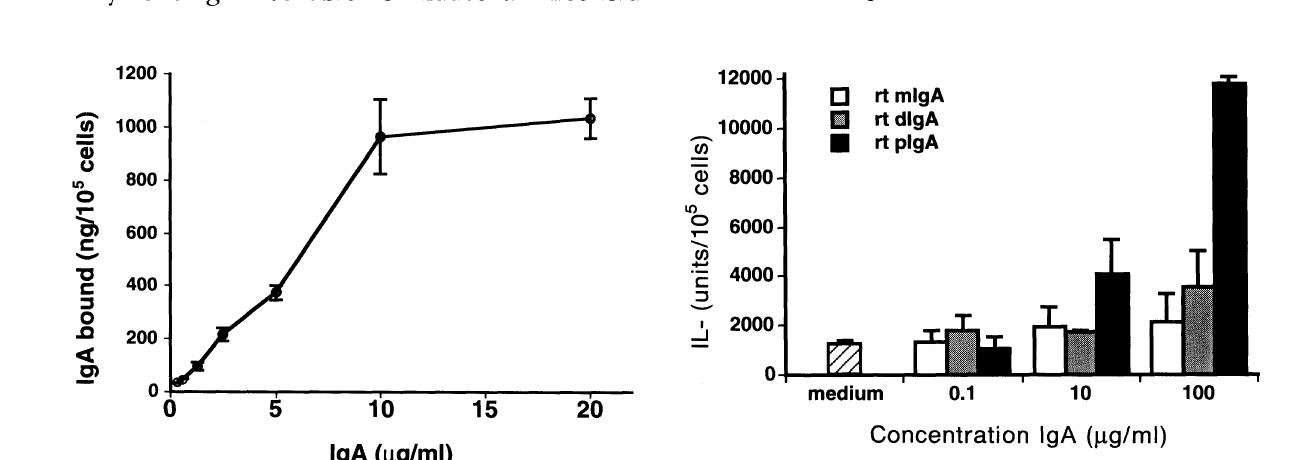
FIG. 3. Effect of increasing concentrations of rat monomeric, dimeric or polymeric IgA on the production of IL-6 by MC in vitro. MC were incubated with various IgA preparations in tripli- cate for 72 h. After incubation, the supernatants were harvested and assessed for IL-6. One of three representative experiments is shown. Results are expressed as the mean